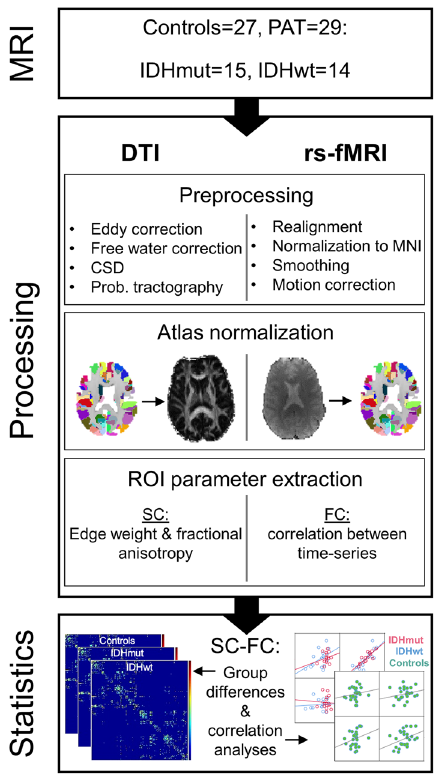
Figure 1. Flowchart of applied methods. The MRI examination was acquired preoperatively from 29 patients (PAT), of which 15 had isodehydrogenase (IDH) mutated, and 14 had wildtype gliomas. After tumor segmentation, diffusion tensor images (DTI) and resting-state functional MRI (rs-fMRI) data were preprocessed, and Brainnetome Atlas-based regions of interest (ROI) were extracted. Within these ROIs, the structural and functional connectivity (SC and FC) was computed to analyze between-group connectomic differences, as well as intra- and intermodal correlations for each